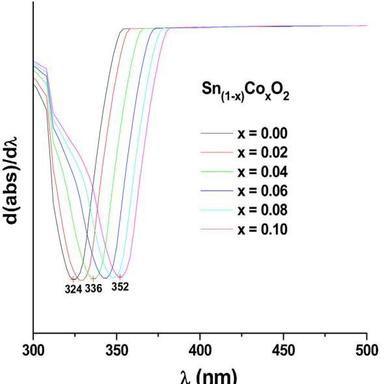
Absorbance derivative with wavelength of Sn1−xCoxO2 (with 0 ≤ x ≤ 0.10) nanoparticles.